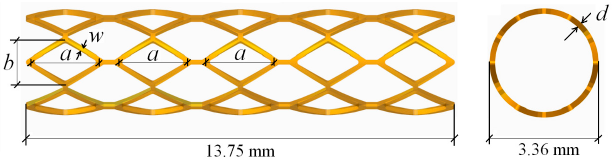
Figure 1. Generic polymeric stent with straight bridges based on the ART18Z platform.